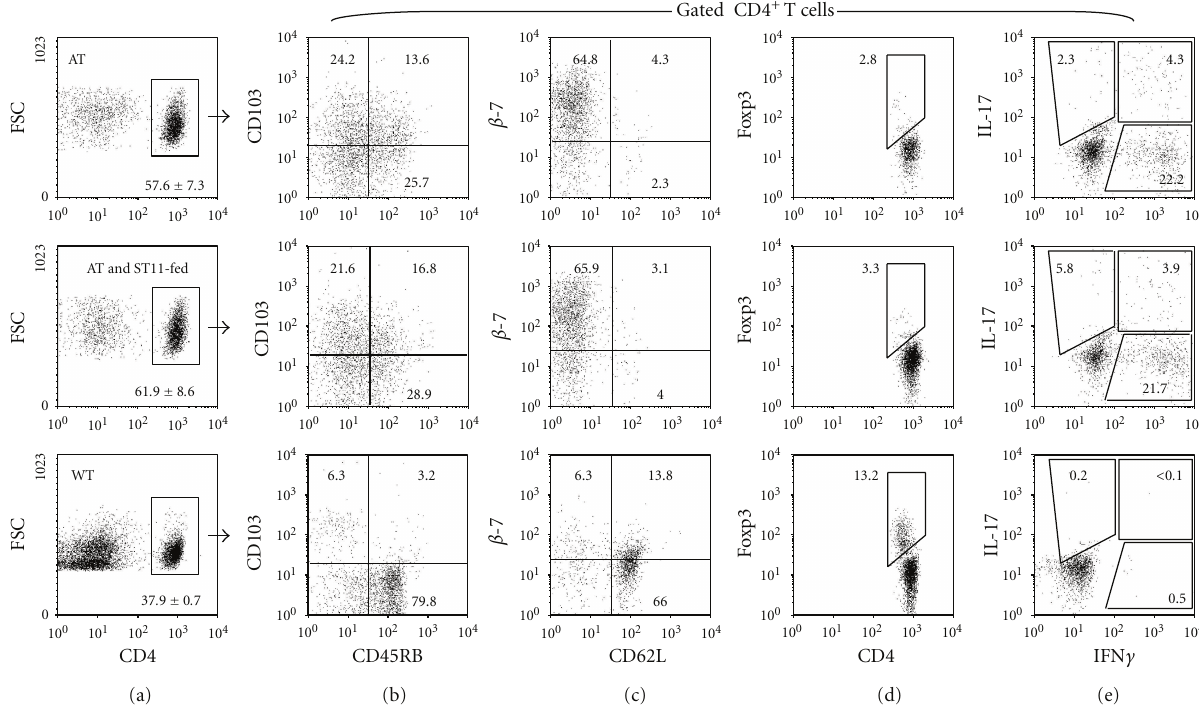
Figure 4: Phenotypic and functional characteristics of T cells after transfer. 5 × 10 5 sorted na¨ıve T cells were adoptively transferred into Rag2 − / − mice. (a) At week 4, mesenteric lymph node cell suspensions were made, stained, and analyzed by flow cytometry. CD4 + cells repopulated PBS-fed recipient mice (AT) as e ffi ciently as ST11-fed mice (AT and ST11-fed). As control, representative staining obtained with CD4 + cells from unmanipulated C57BL/6 wild-type mice (WT) are shown (lower dot plots) because unmanipulated Rag2 − / − mice do not contain CD4 + T cells. (b-d) Phenotype of gated CD4 + T cells was assessed by FoxP3, CD45RB, CD62L, CD103, and integrin β 7 staining as well as (e) IL-17 and IFN γ secretion upon in vitro stimulation. Percentages are indicated in dot plots. Data are representative of two independent experiments made with 3-4 animals each